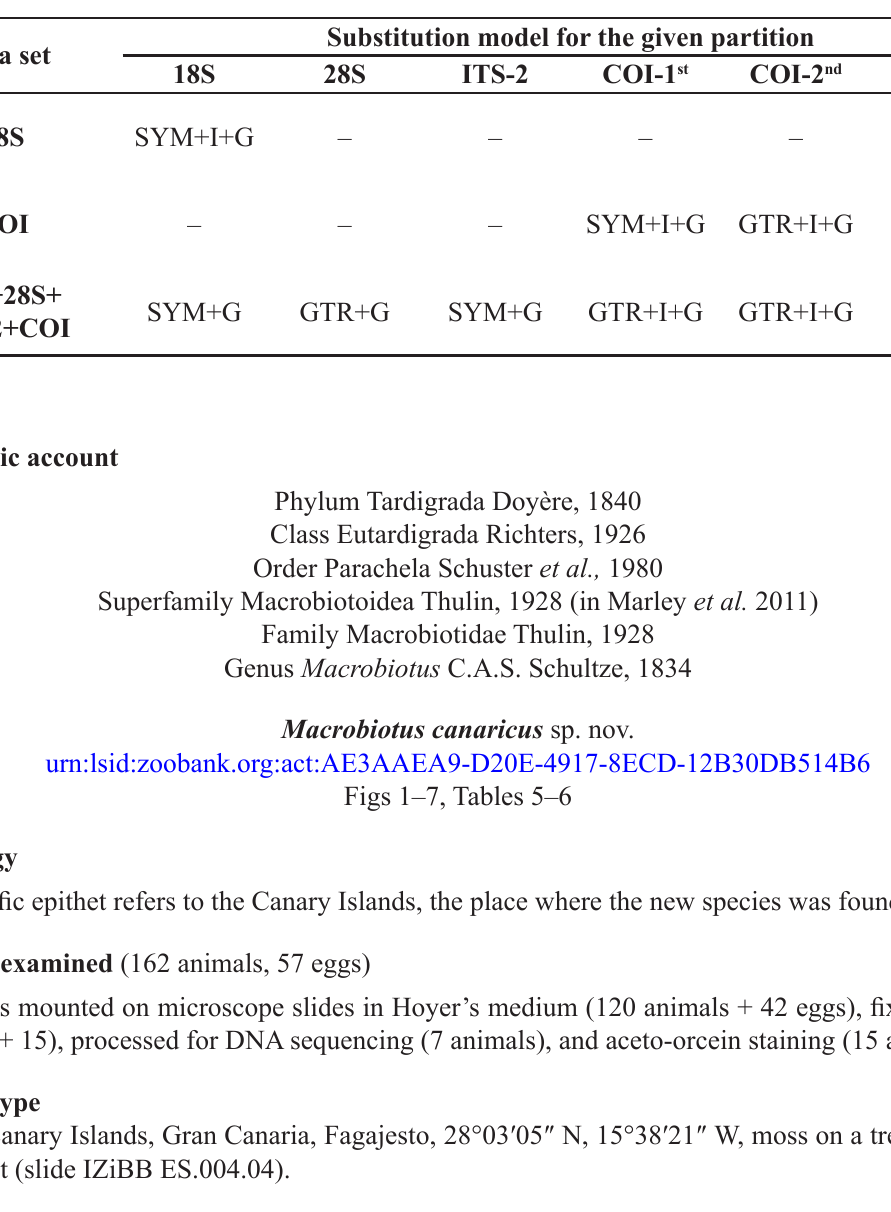
Table 4. The best scheme of partitioning and substitution models chosen for posterior phylogenetic analysis using PartitionFinder v. 2.1.1 under the Bayesian Information Criterion (BIC). The analyses were run to test all possible models implemented in the